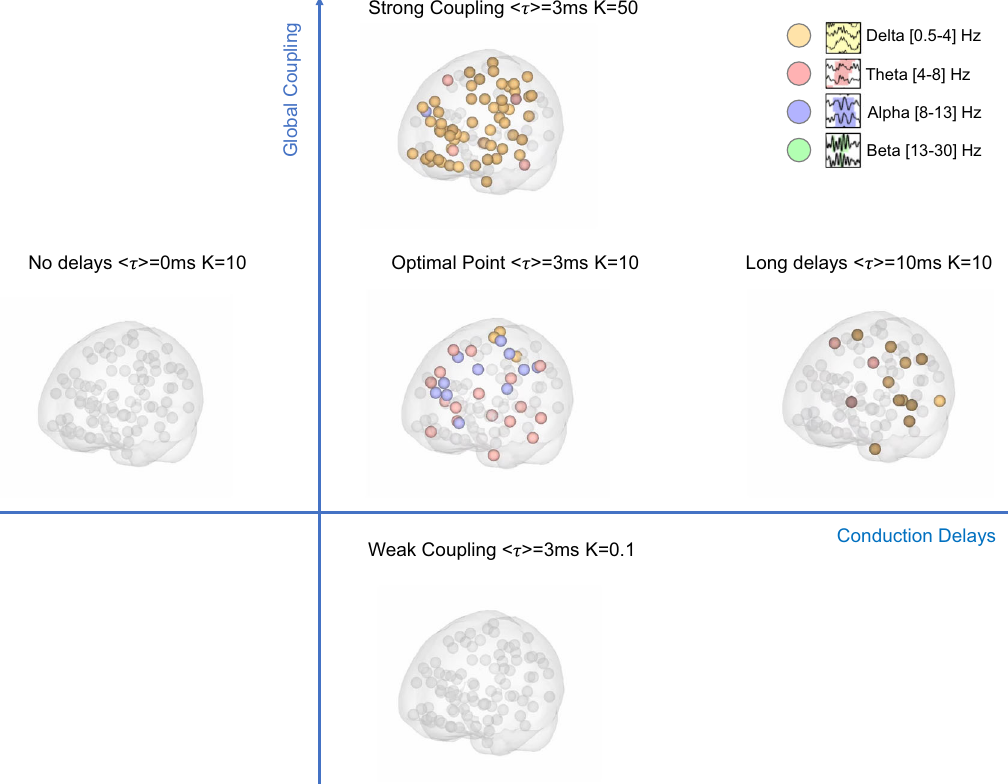
Fig. 7 Metastable Oscillatory Modes (MOMs) emerge transiently from interactions in the Connectome spacetime structure only for suf fi cient coupling and conduction times. Each brain area is represented as a sphere located at its centre of gravity. A color code is used to highlight the brain areas with power exceeding fi ve standard deviations from the baseline power at a given time point. This image is a still frame from Supplementary Movie 1. While the structural connectome is the same for all simulations, MOMs only emerge at reduced frequencies in the presence of Conduction Delays 〈 τ 〉 and for suf fi cient Coupling strength